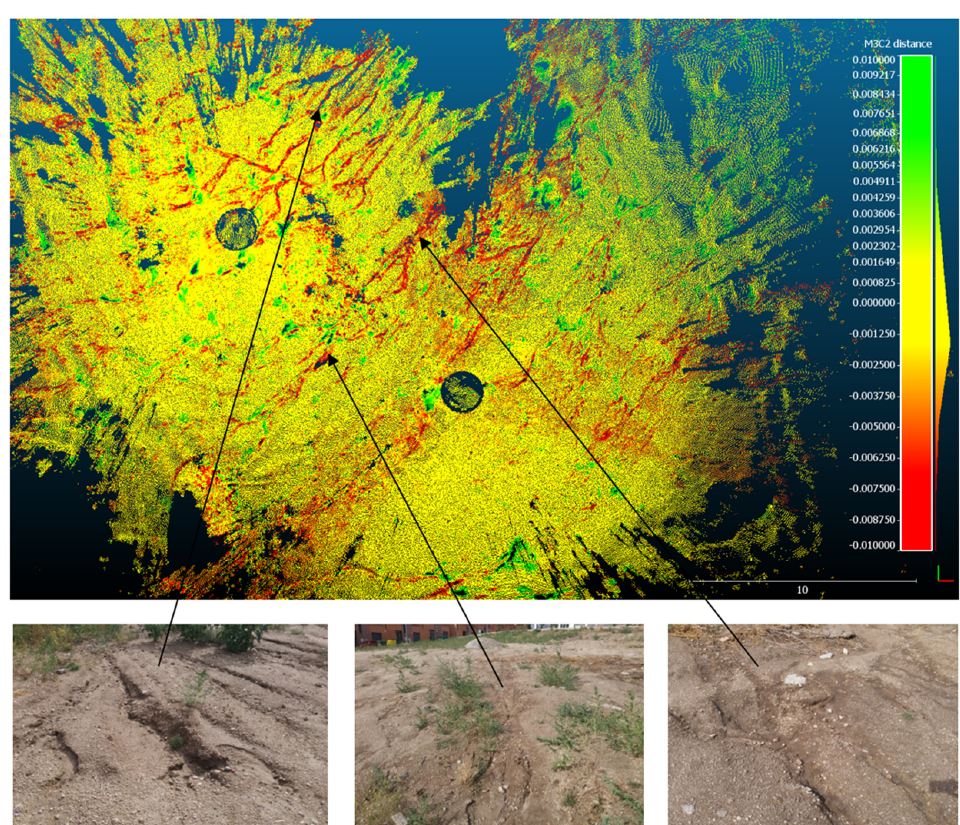
Figure 8. Detail of the result provided by the M3C2 algorithm. Notice the red in the image corre-